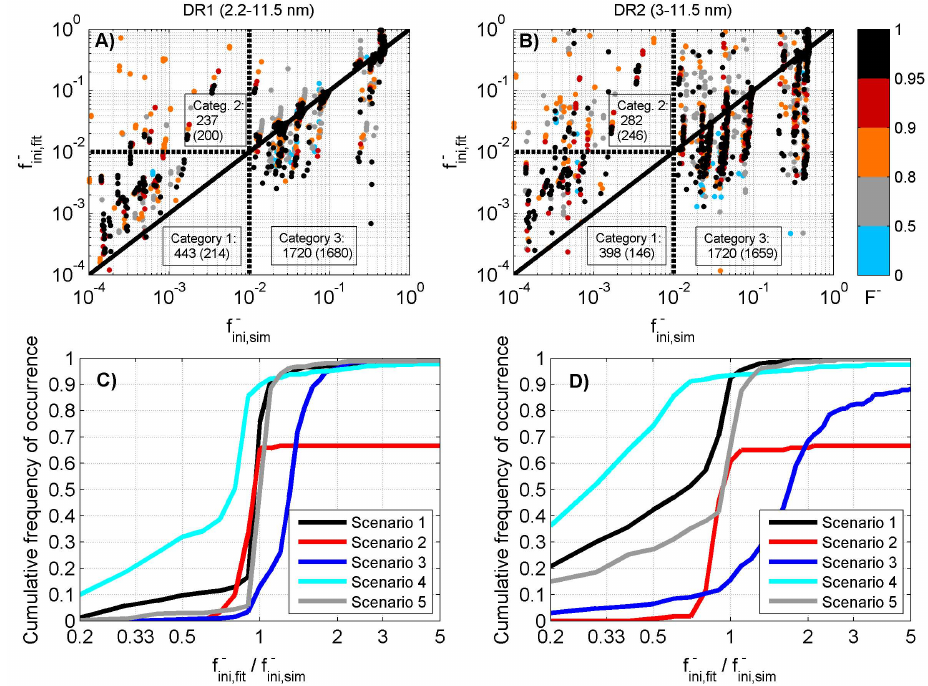
Fig. 8. As Fig. 7, except that the initial charged fractions on the y-axis of (A) and (B) are determined using the fitting method, instead of the iteration method, and the cumulative frequencies of occurrence shown in (C) and (D) are changed